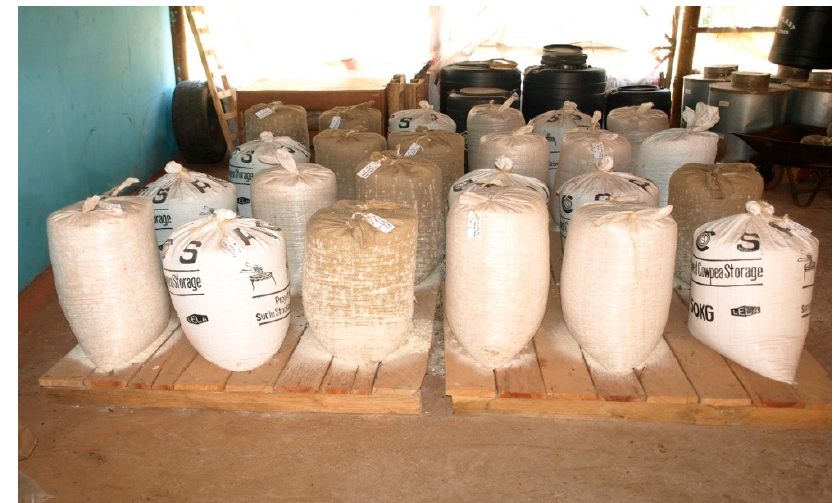
Figure 2. Side by side storage of PICS, PP and Jutes bags during the experiment at the KARLO research station in Kiboko, Kenya. Insects seriously damaged PP and Jute treatments, as reflected in the dust produced.